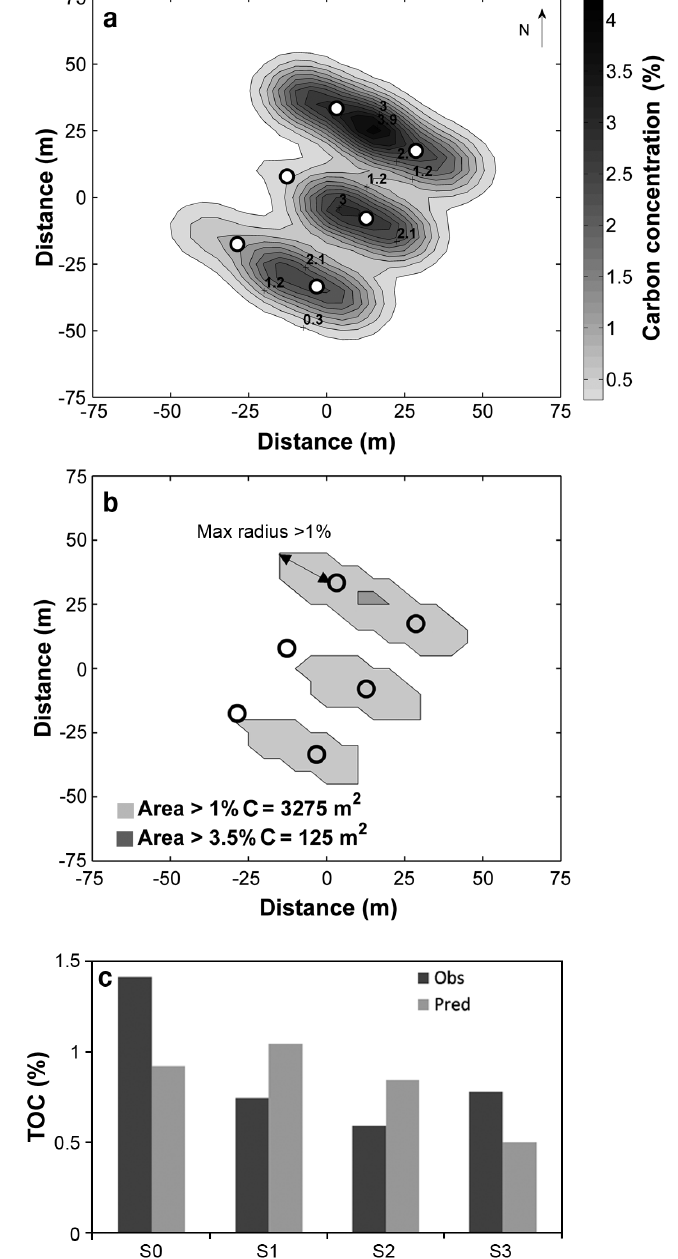
Fig. 8. (a) Modelled organic carbon concentration (%) in the upper sediment at the end of the simulated period; (b) zones of intermediate and high organic enrichment underneath the farm studied in Bisceglie; (c) comparison between observed (Obs) and model-predicted (Pred) total organic car- bon (TOC) concentration at 4 stations located underneath the farm (see Fig. 1). Arrow in (b) shows the maximum radius of the area with carbon concentrations